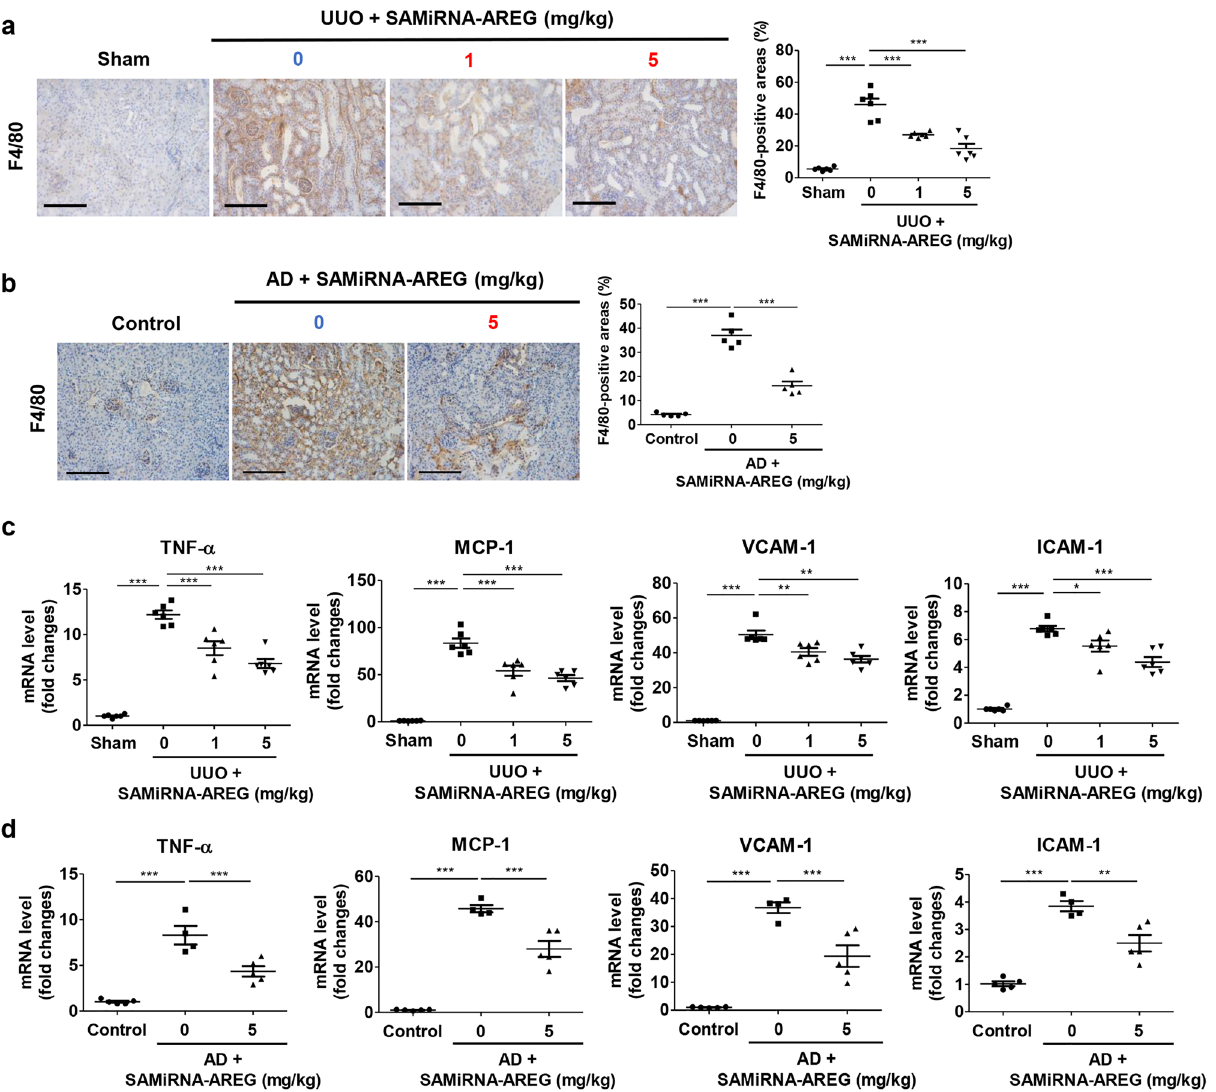
Figure 6. SAMiRNA-AREG ameliorated inflammatory cytokine levels and adhesion molecules in UUO- or AD-induced models. ( a , b ) Representative images of F4/80 expression in UUO and AD mice. The F4/80-positive areas were quantified. Scale bar, 100 μm. ( c , d ) Kidney tissue lysates were subjected to real-time qRT-PCR analysis of inflammatory markers (TNF-α and MCP-1) and adhesion molecules (VCAM-1 and ICAM-1) using RPL13A as the standard. * p < 0.05, ** p < 0.01, *** p < 0.001 compared to UUO or AD